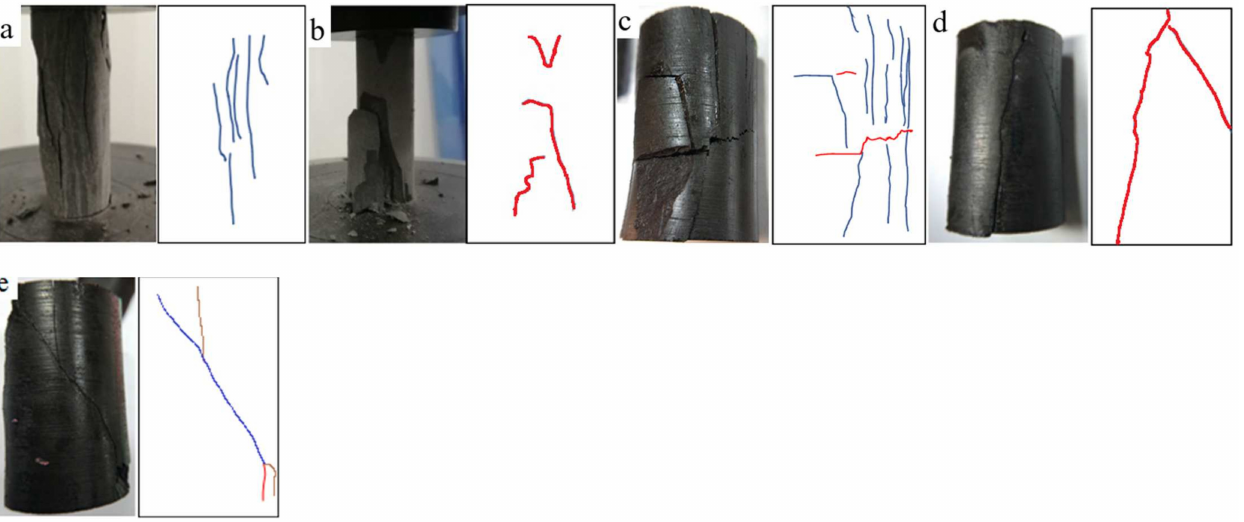
Figure 9. Shale samples after compression tests and schematic diagram of fractures: ( a ) the dry sample with an axial direction—lamina angle of 0 ◦ after uniaxial compression test; ( b ) the dry sample with an axial direction—lamina angle of 90 ◦ after uniaxial compression test; ( c ) the sample hydrated in distilled water at 80 ◦ C for 48 h with an axial direction—lamina angle of 0 ◦ after triaxial compression test under confining pressure of 30 MPa; ( d ) the samples hydrated in distilled water at 80 ◦ C for 48 h with an axial direction—lamina angle of 90 ◦ after triaxial compression test under confining pressure of 30 MPa; ( e ) the sample hydrated in distilled water at 80 ◦ C for 48 h with an axial direction—lamina angle of 30 ◦ after triaxial compression test under confining pressure of 30 MPa. The blue line indicates the failure line along the lamina, the red line indicates the failure line intersected with the